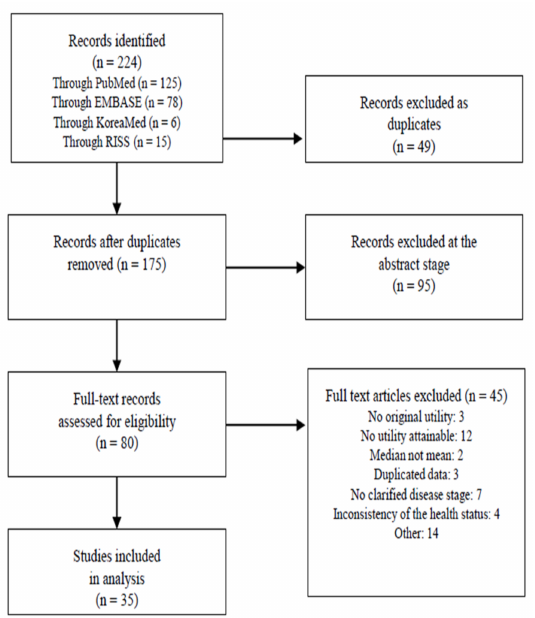
Figure 1. Flow diagram of the systematic review of breast cancer utility studies.